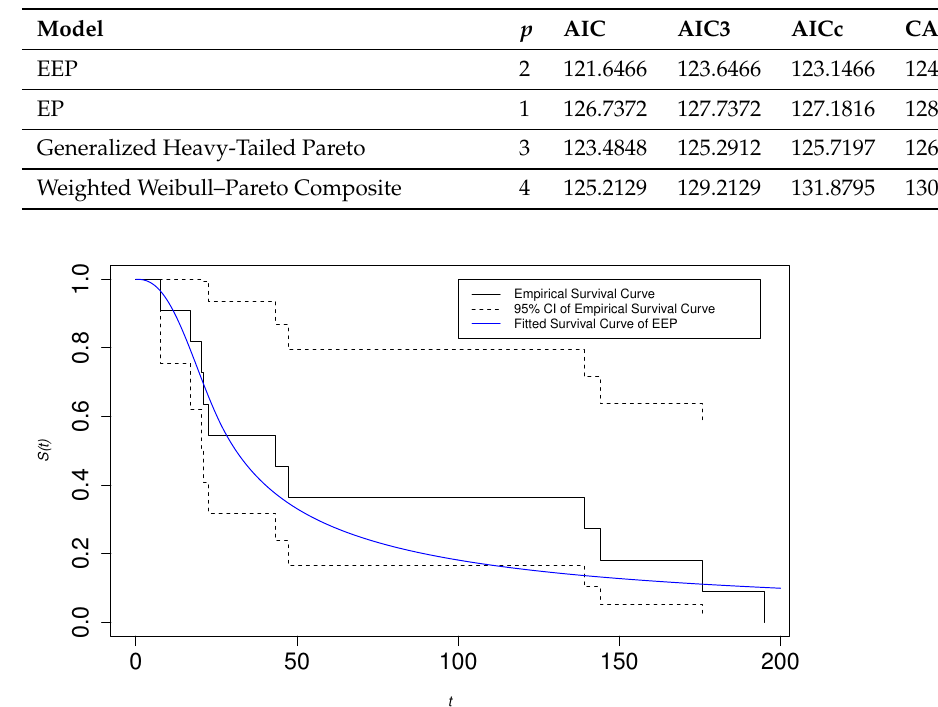
Table 7. Comparison of the four models in terms of the five GoF measures.